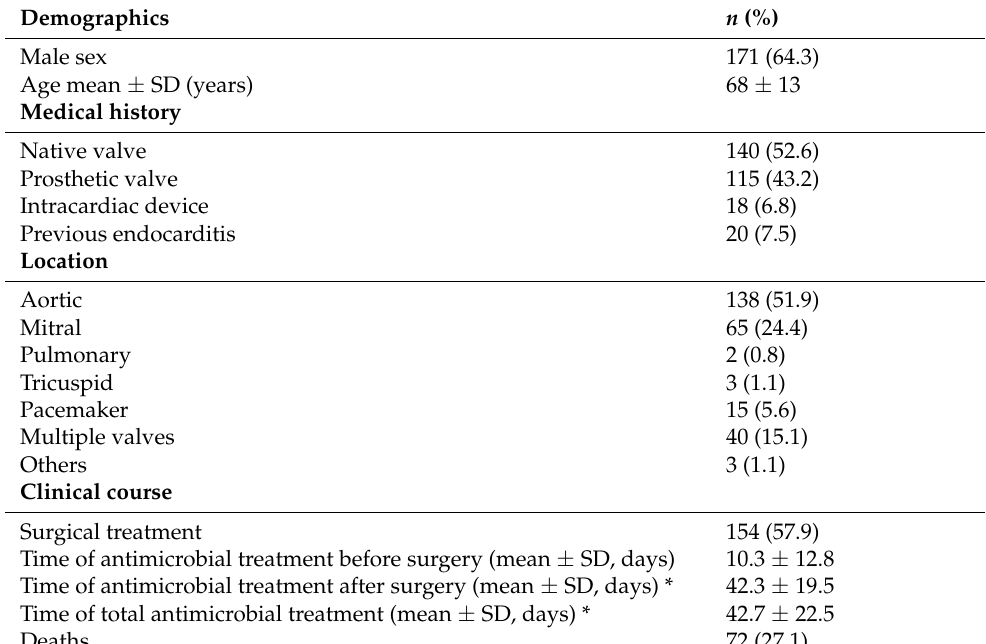
Table 1. Clinical features of patients with infective endocarditis included in the